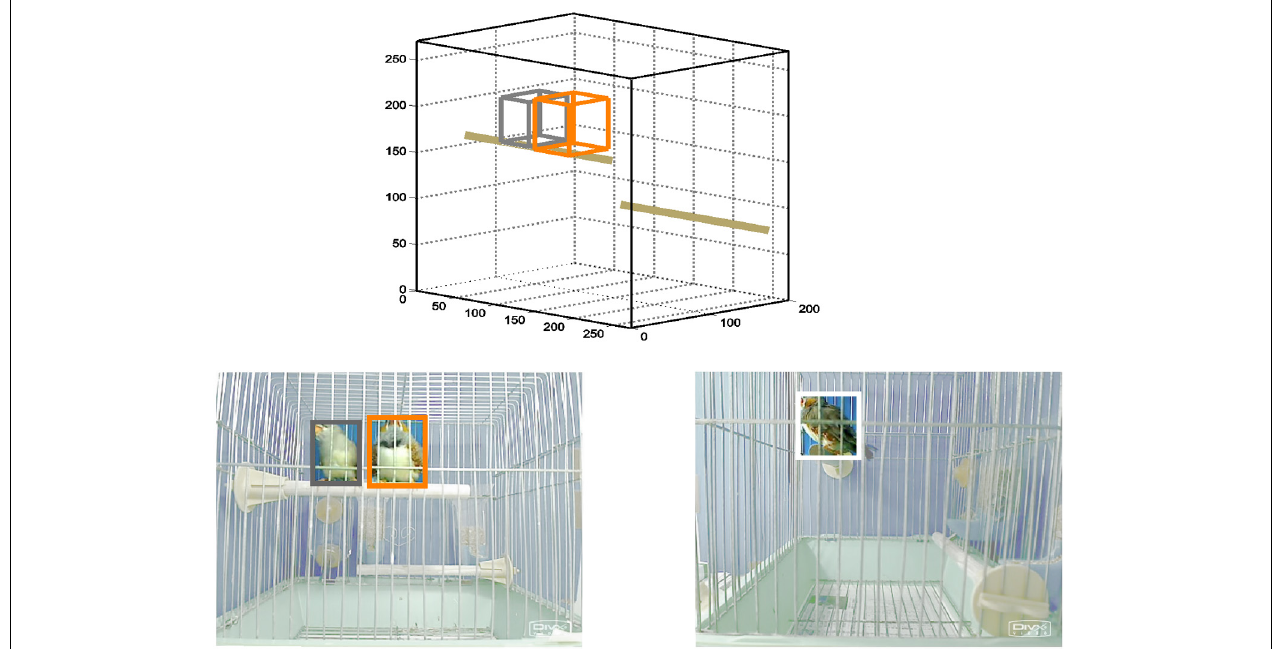
FIGURE 1 | Schematic of system for automatic tracking of individual birds during interaction sessions. Lower left and right panels are images obtained by two webcams positioned outside the front and side of a cage containing a female and a male zebra finch. Software could identify and discriminate between female and male birds (outlined in gray